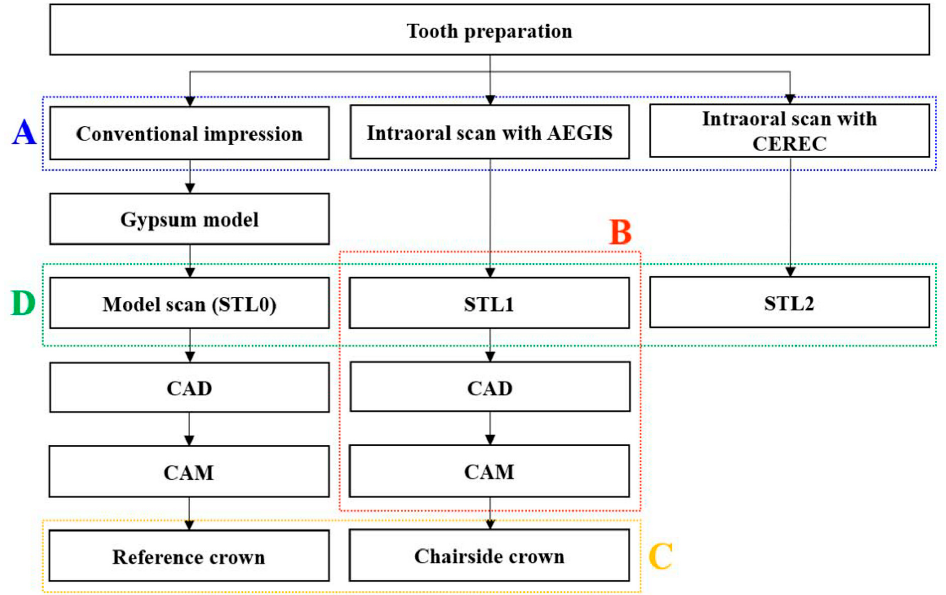
Figure 2. Overview of this study, A , Impression time; comparison of the time taken to obtain impressions by the conventional and intraoral scanning methods, B , Total working time; total working time for fabricating the chairside crown, C , Replica measurement; evaluation of marginal and internal fit of the two crowns, D , Best fit alignment; evaluation of the accuracy of intraoral